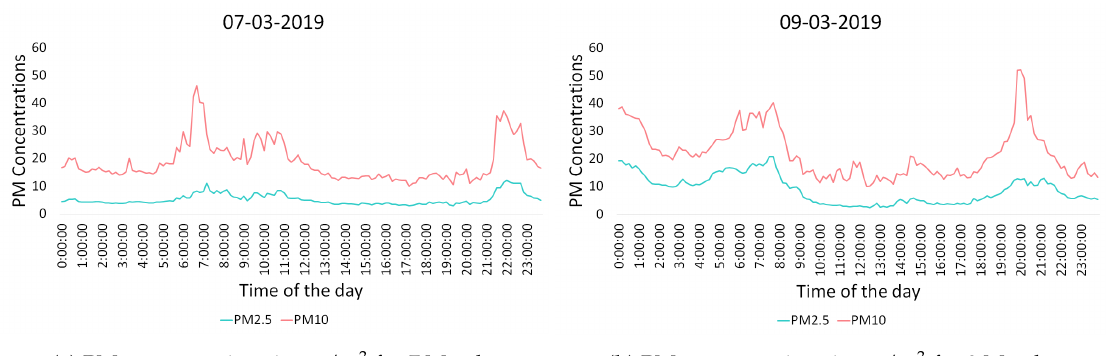
Figure 14. PM concentrations for two random days in the neighborhood of